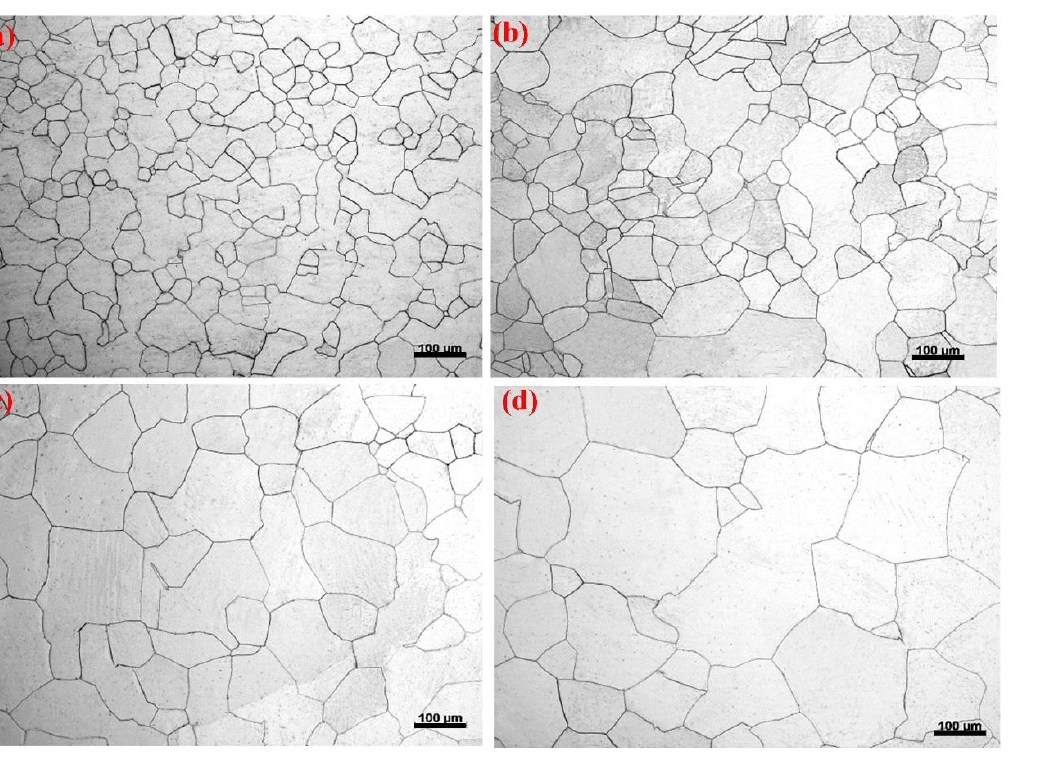
Figure 1. Optical micrographs showing the homogeneous microstructures with different grain size at different annealed conditions: ( a ) 350 °C, ( b ) 400 °C, ( c ) 450 °C, and ( d ) 500 °C.